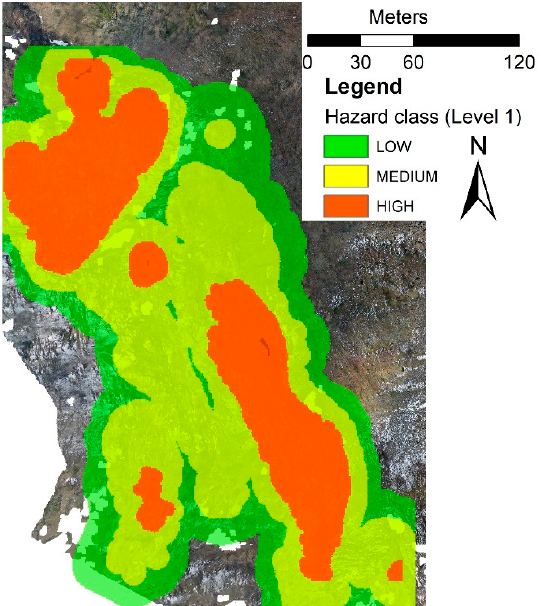
Figure 10. Level 1 hazard map. Orthophoto of the study area with identification of zones at different levels of hazard.